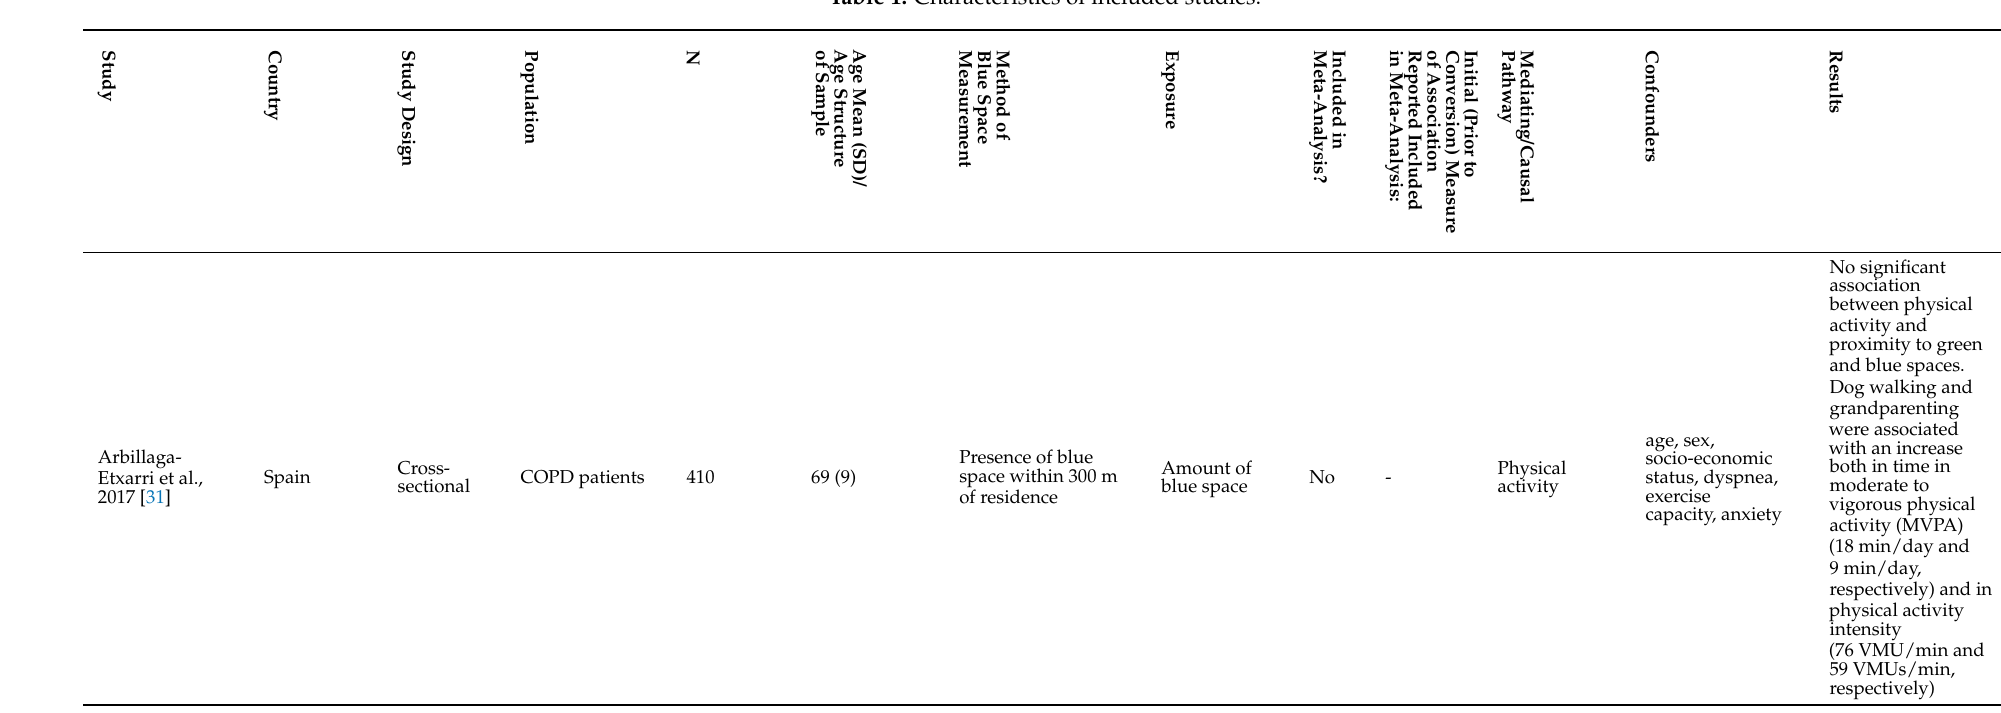
Table 1. Characteristics of included